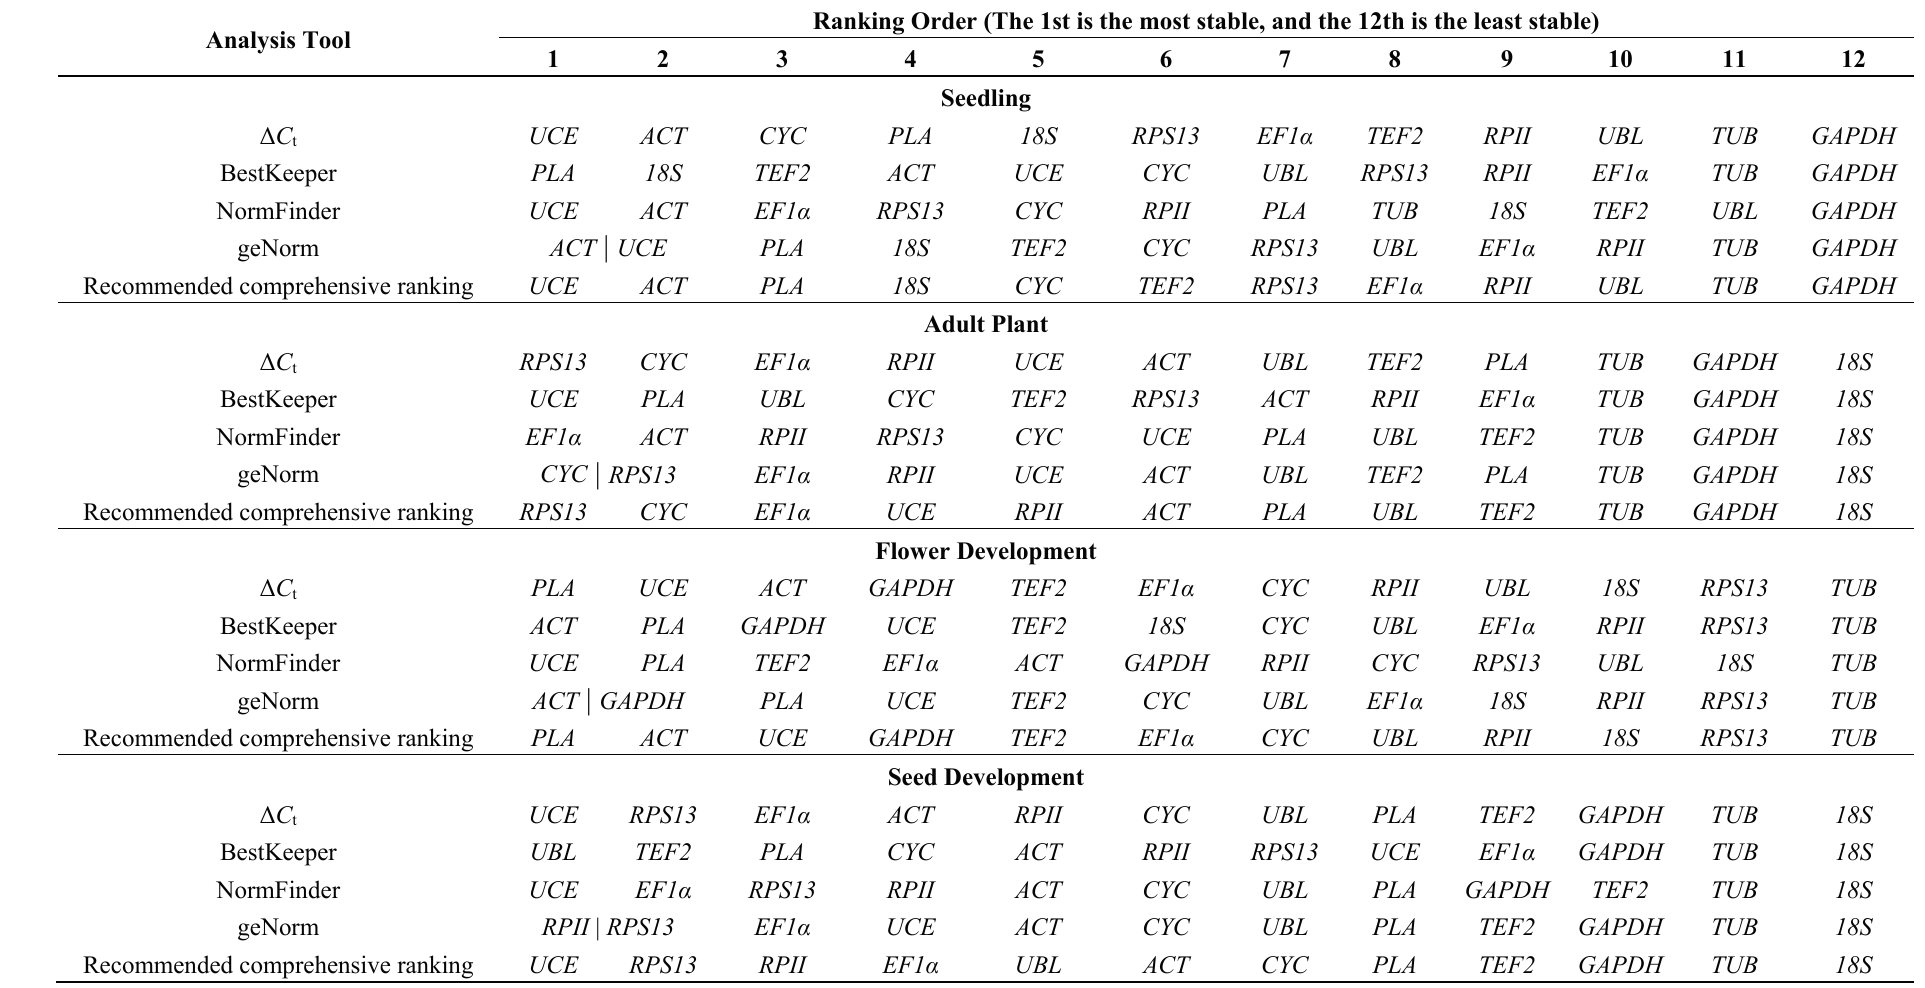
Table 2. Stability ranking of candidate reference genes in different developmental